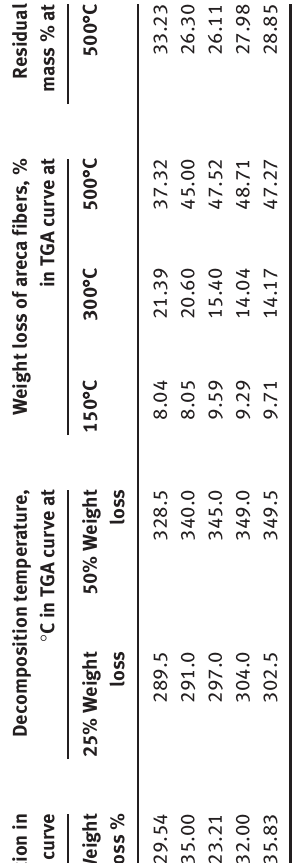
Table 2: Derivative thermogravimetric (DTG) results of untreated